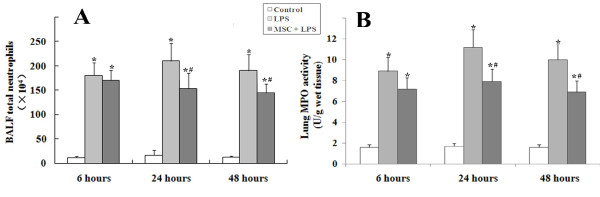
(A) BALF neutrophil counts and (B) lung MPO activity. Neutrophil counts and lung tissue MPO activity were significantly higher in the LPS group compared to the control group. Treatment with UC-MSCs significantly reduced the LPS-induced increase in BALF neutrophil counts and lung MPO activity at 24 and 48 hours (*, p < 0.05 compared with healthy controls; #, p < 0.05 comparing LPS plus UC-MSCs with LPS alone).